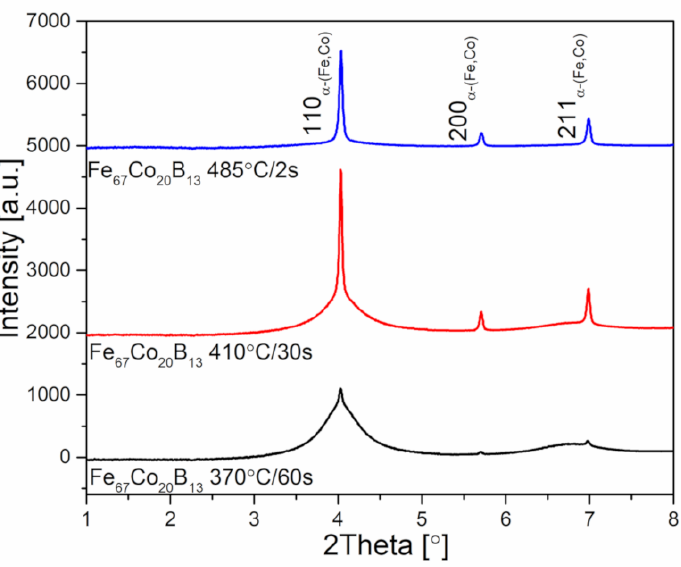
Figure 8. High-energy X-ray diffraction patterns of heat treated Fe 67 Co 20 B 13 ribbons.